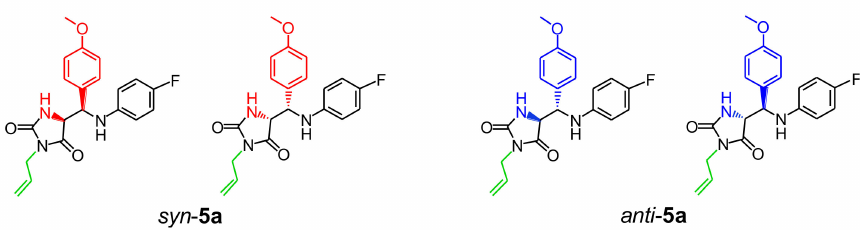
Figure 3. All four possible stereoisomers of allylhydantoin 5a